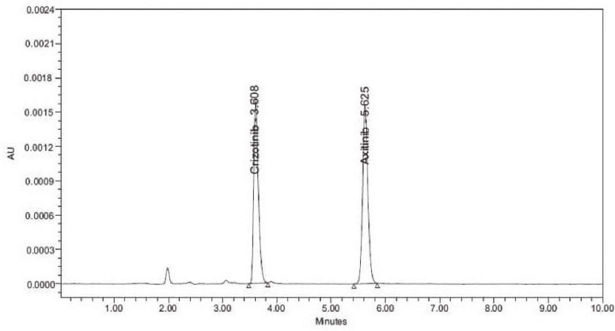
FIGURE 5 - Chromatogram of MQC.